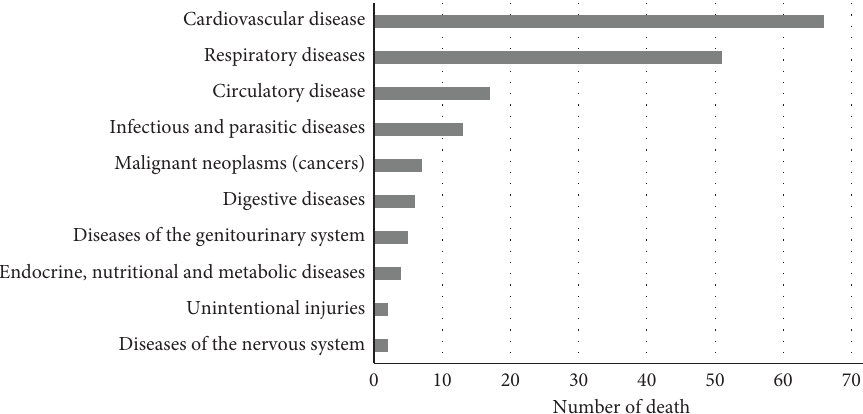
Figure 5: Te cause of death according to the hospital/fight doctor death